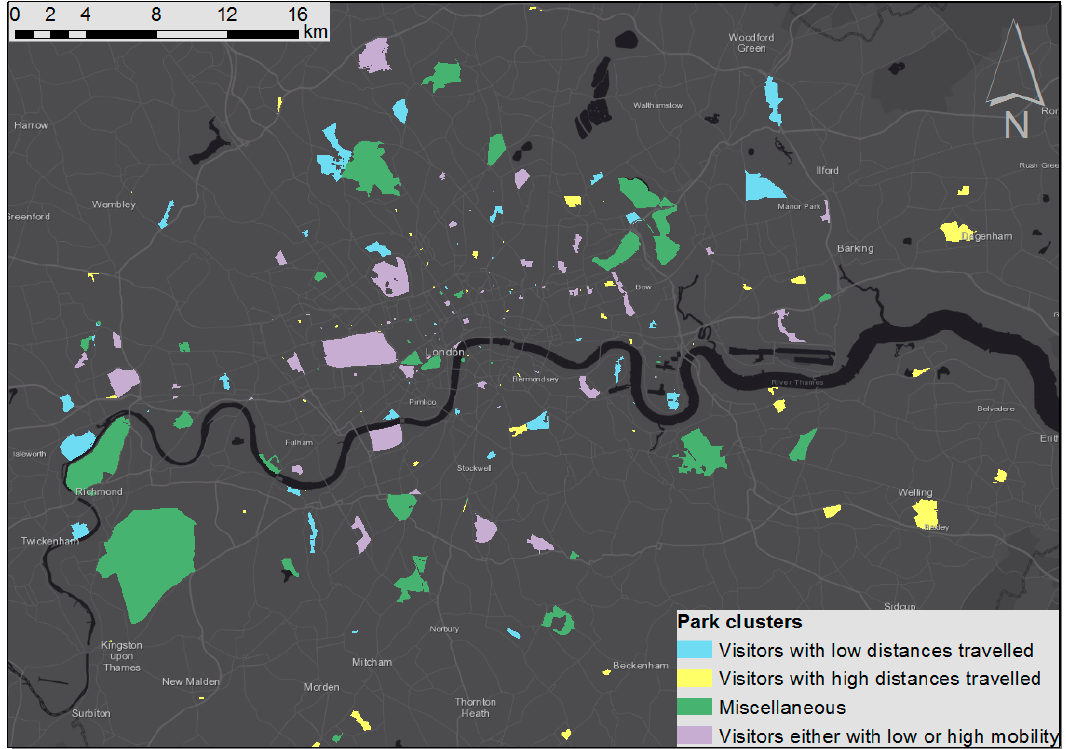
Figure 10. Park categories based on the spatial characteristics of their visitors’ behavior.